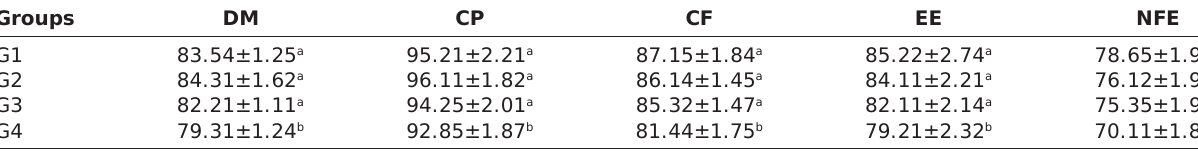
Table-4: Digestibility coefficient (%) of diets used in different groups. Groups